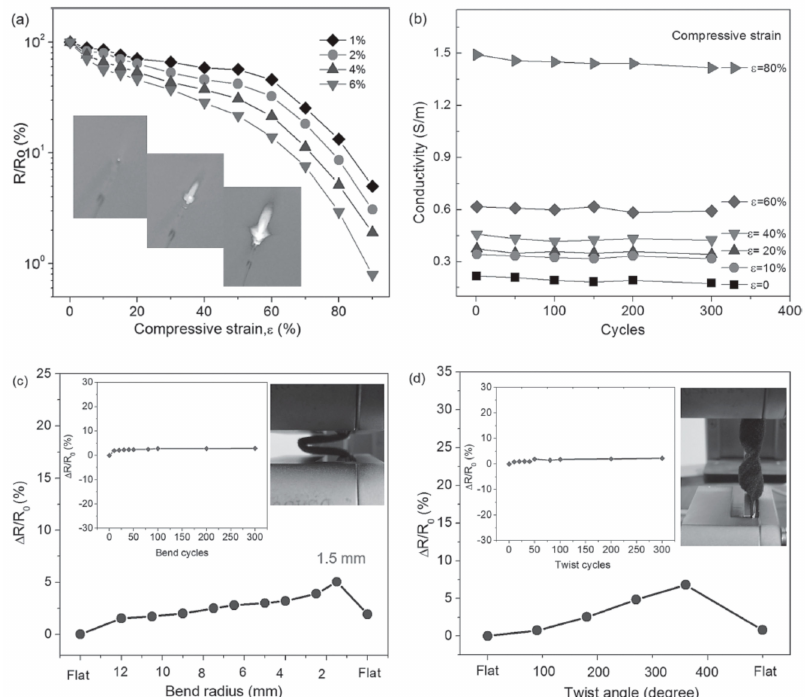
Figure 11. Resistance and conductivity of graphene / polyurethane (PU) composites. ( a ) Resistance change with strain for di ff erent graphene concentrations; ( b ) Electrical conductivity of composites with 6% graphene after compression-release cycles; ( c ) Resistance change with bending radius with 6% graphene; ( d ) Resistance change with twist angle with 6% graphene. Reproduced with permission from [119]. Copyright 2013, John Wiley & Sons.